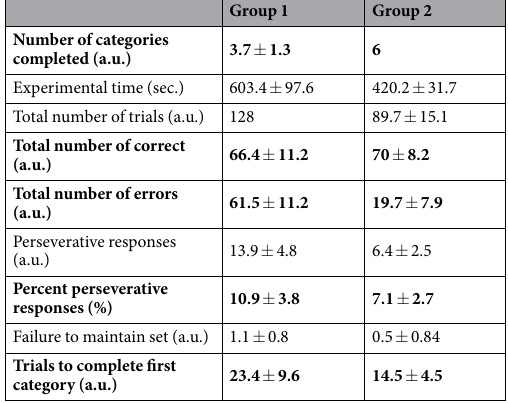
Table 1. WCST parameter with values averaged for each group.